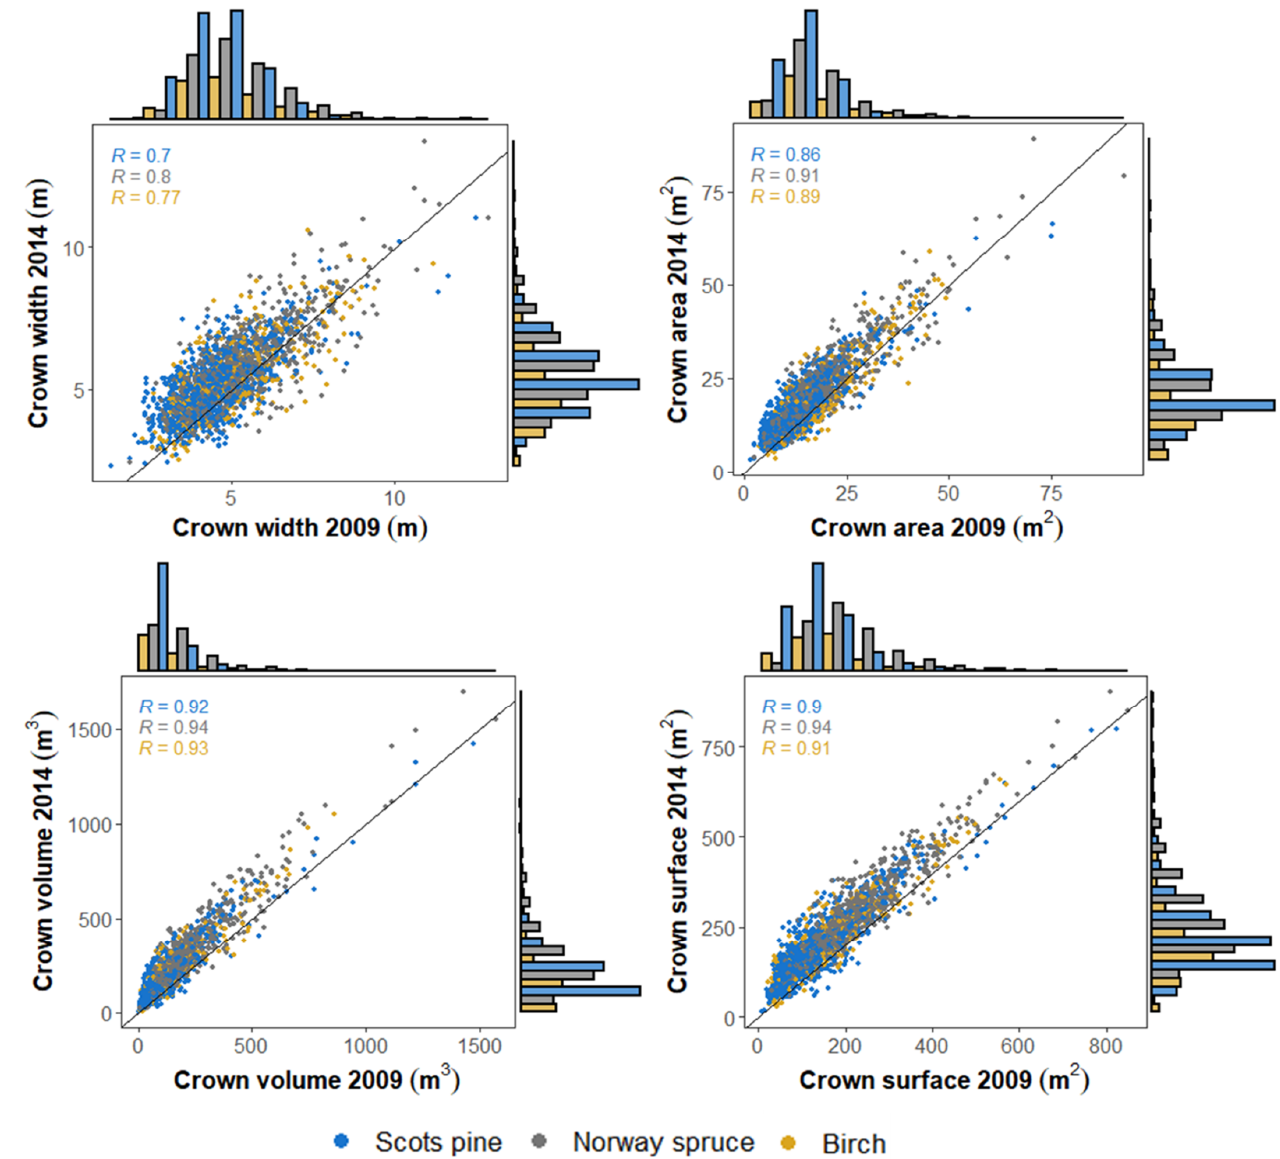
Figure 5. Consistency of ALS-derived species-specific crown metrics in T1 (2009) and T2 (2014).